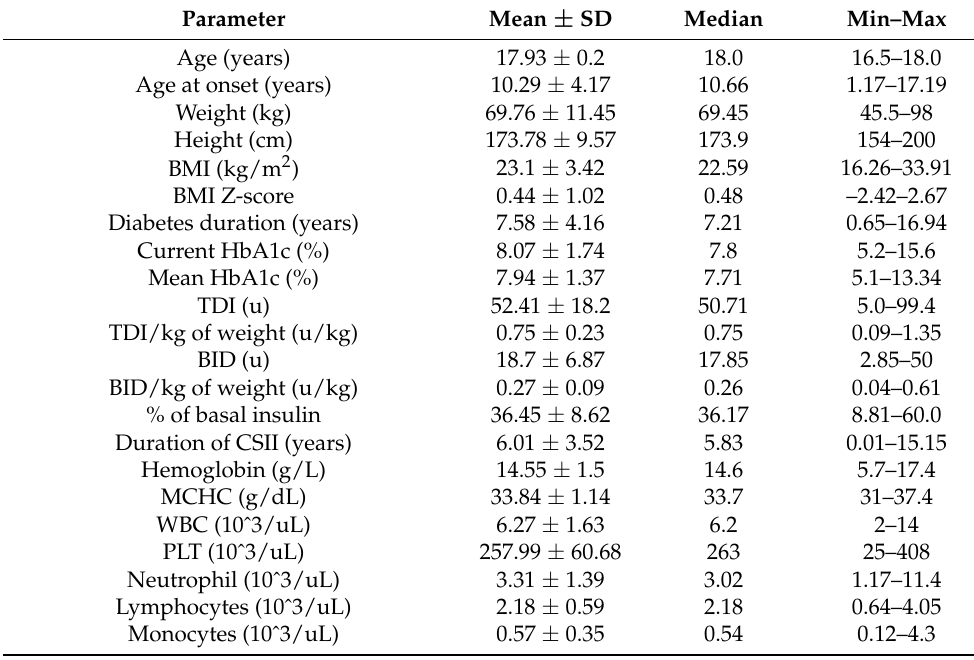
Table 3. Demographic, metabolic, biochemical, and treatment data of the studied